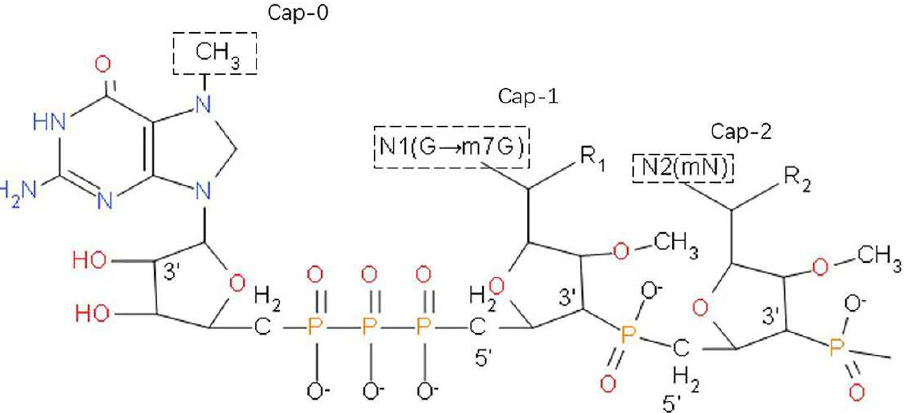
Figure 7. The 5′ cap of a eukaryotic mRNA chemical structure. Cap-0: add methyl to the 7-position of terminal G so that it has the cap of a single methyl group. Cap-1: add a methyl group to the second-base sugar chain 2′-O position. Cap-2: the 2′-O position of the third-base sugar chain will be methylated in the presence of Cap-1. Reprinted with permission from [124] .